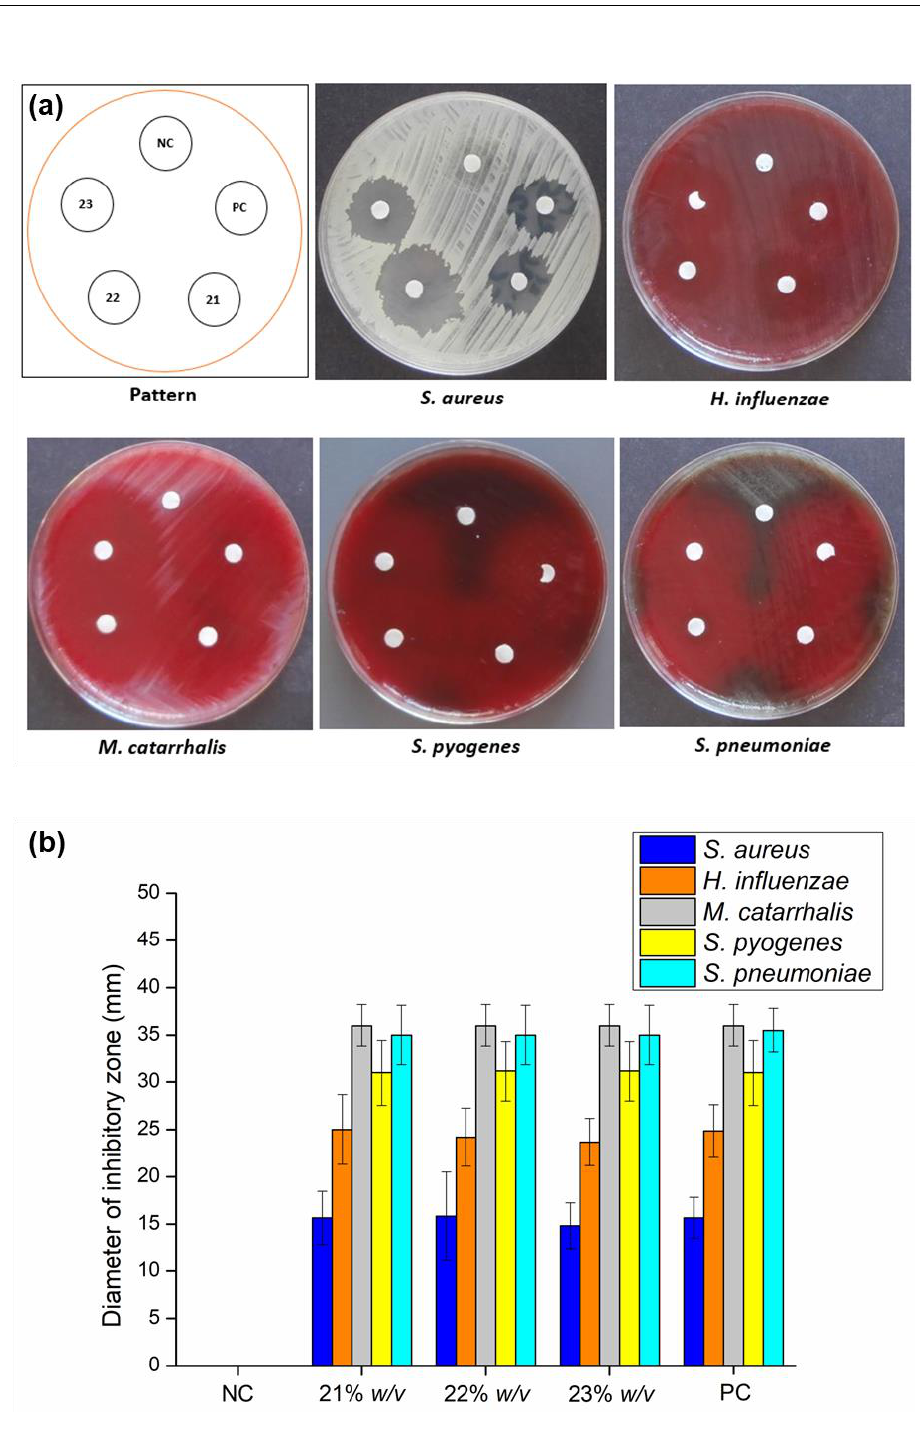
Figure 7. Disk diffusion test zone of AMT-free BSA-P407, as negative control (NC); 1 mg/mL AMT aqueous solution, as positive control (PC); and in situ gelling AMT-BSA nasal gel formulations (containing 21, 22, and 23% w / v of P407). ( a ) Diameter of the inhibitory zone formed against five investigated bacteria ( S. aureus; H. influenzae; M. catarrhalis; S. pyogenes; and S. pneumoniae ). ( b ) Data are presented as means ± SD, n = 5.